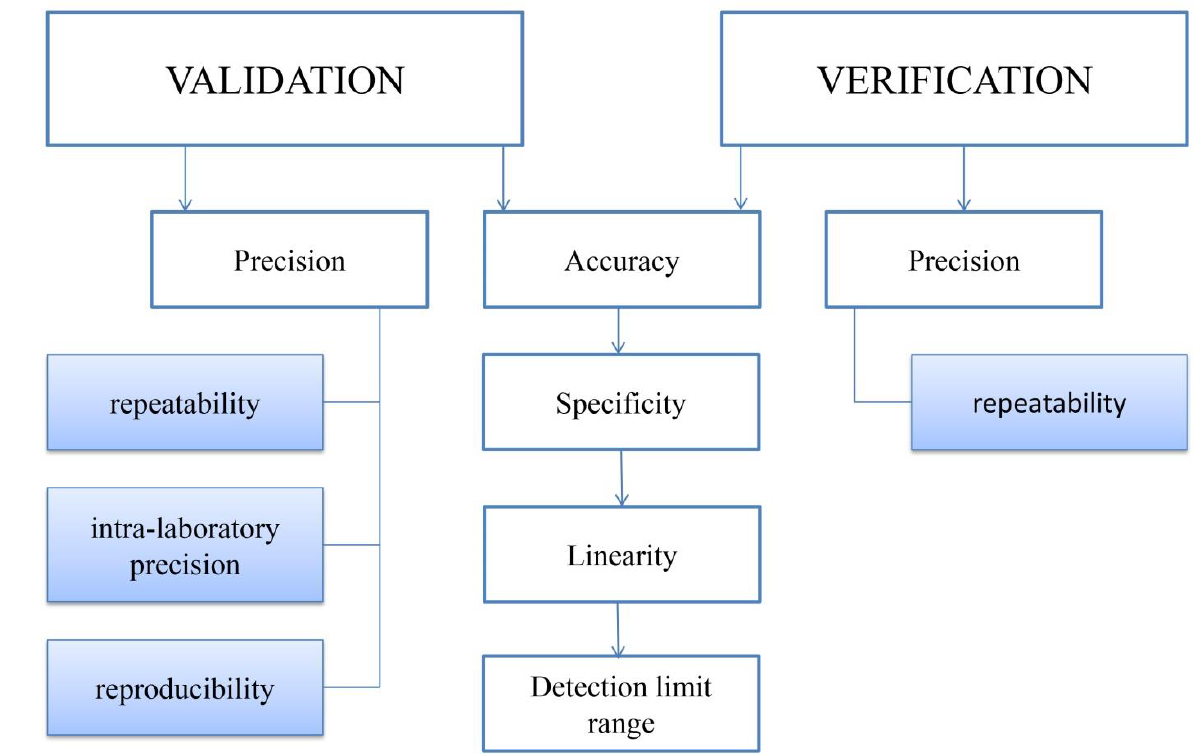
Fig. 1. Comparison of validation characteristics of quantitative determination methods during validation and